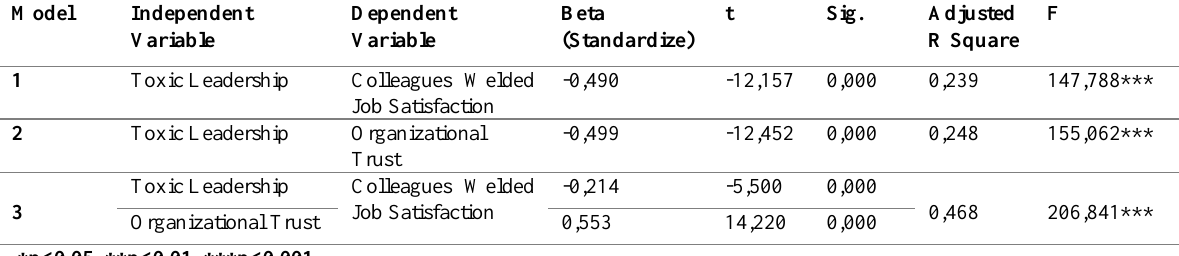
Table 8: The Effect of Toxic Leadership on Colleagues Welded Job Satisfaction through the Mediation of Organizational